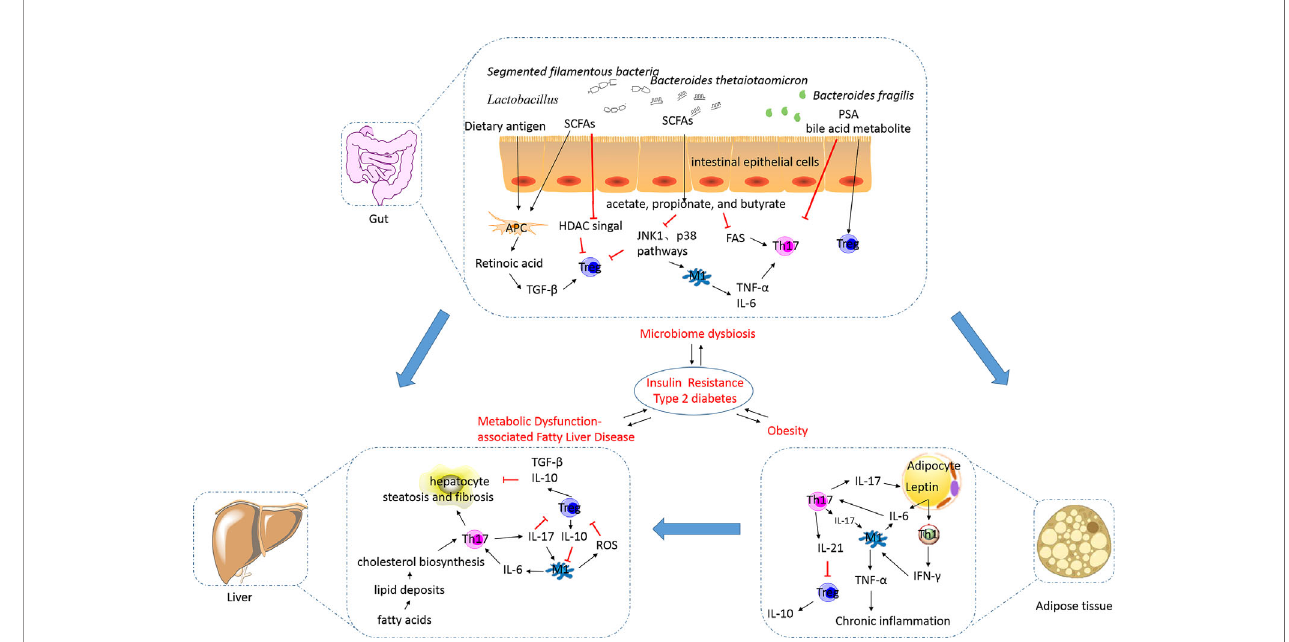
FIGURE 2 | The alterations in and the roles of the Th17/Treg balance in metabolic disorders. Excess nutrition can result in the development of obesity and metabolic dysfunction-associated fatty liver disease, and this phenomenon is reportedly in fl uenced by the gut microbiota. This results in the development of insulin resistance, diabetes, metabolic syndrome, and related cardiovascular complications (their relationships were showed by blue arrows). In obesity, adipocytes can secrete proin fl ammatory cytokines, including IL-6, to increase the number of Th17 cells. Th17 cells stimulate macrophages towards an in fl ammatory signaling cascade. IL-17 secreted by Th17 cells targets adipocytes and participates in the proin fl ammatory signaling. IL-21 secreted by Th17 cells can inhibit Treg cell differentiation and function. The decreased number of Treg cells in visceral adipose tissues is inversely correlated with the body mass index and plasma leptin levels. Increased release of free fatty acids by white adipose tissue causes hepatocyte injury and leads to the synthesis of proin fl ammatory cytokines. IL-17A increases cytokine production in hepatocytes and macrophages, thereby inducing steatosis and fi brosis. M1 macrophages can inhibit the function of Treg cells via ROS-induced apoptosis. TGF- b and IL-10 secreted by Treg cells are involved in the exertion of anti-in fl ammatory effects. The intestinal microbiota is essential for the development of obesity and plays an important role in regulating NAFLD progression. Translocation of bacteria and bacterial products activates in fl ammasomes and stimulates proin fl ammatory cytokines to cause a shift in the Th17/Treg balance. Lactobacillus reuteri, Bacteroides fragilis , Bacteroides thetaiotaomicron , Clostridium , and Faecalibacterium prausnitzii promote Treg cell differentiation. Segmented fi lamentous bacteria are necessary for the development of the gut Th17 cells. SCFAs, as metabolites of microbes such as acetate-, propionate-, and butyrate-producing microbes, can limit Th17 cell and promote Treg cell differentiation. Bile acid transformation mediated by the gut bacteria can increase Foxp3 expression in Treg cells. Th17, T helper 17; Treg, regulatory T; IL, interleukin; TGF, transforming growth factor; SCFA, short- chain fatty acid; PSA, polysaccharide A; HDAC, histone deacetylase; JNK, c-Jun N-terminal kinase; FAS, fatty acid synthesis; TNF- a , tumor necrosis factor alpha; IR, insulin resistance; T2DM, type 2 diabetes mellitus; NAFLD, non-alcoholic fatty liver disease; ROS, reactive oxygen species; IFN- g , interferon